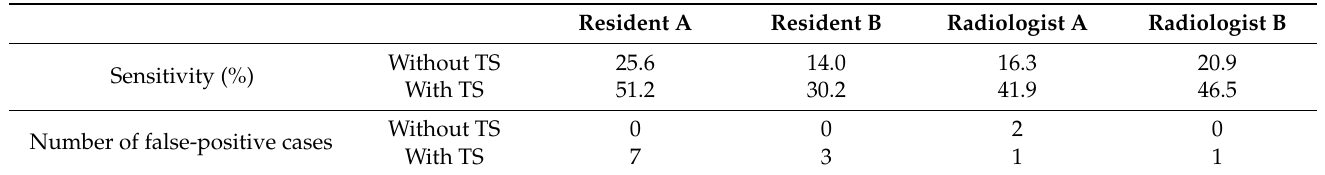
Table 2. The diagnostic performance in detecting newly ectopic bone lesions without and with TS.